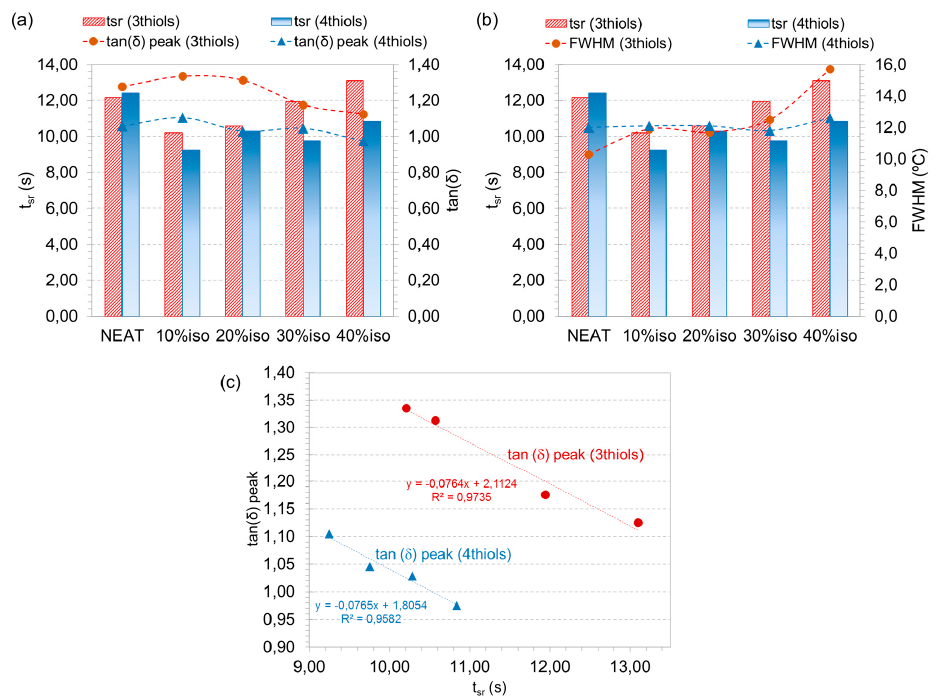
Figure 8. Relation between the shape-memory response (in terms of t sr ) and the network relaxation dynamics; ( a ) t sr against tan δ peak as a function of the composition; ( b ) t sr against FWHM as a function of the composition; ( c ) tan δ peak against the t sr for both, 3thiol and 4thiol with isocyanurate formulations (10%,20%,30% and 40%).